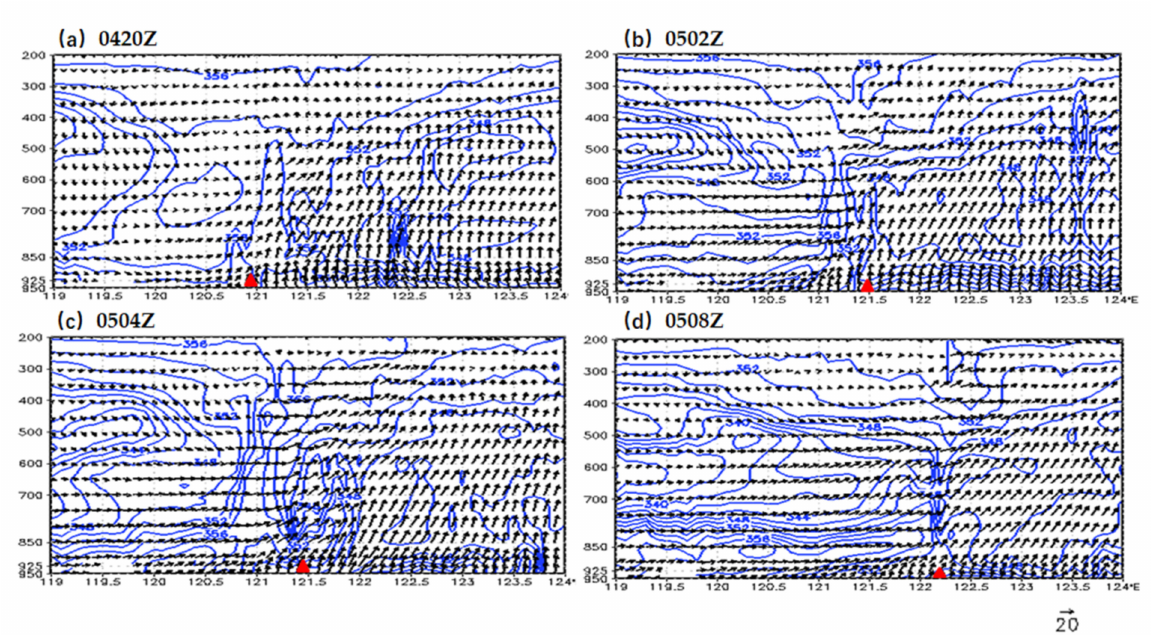
Figure 9. Simulated section of equivalent potential temperature (blue line, unit: K) and wind (vectors, unit: m s − 1 ) along the MCC center 30.5 ◦ N on 4 to 5 August 2020. The red triangle is the center longitude location of MCC. ( a ) 20:00 BT 4, ( b ) 02:00 BT 5, ( c ) 04:00 BT 5, ( d